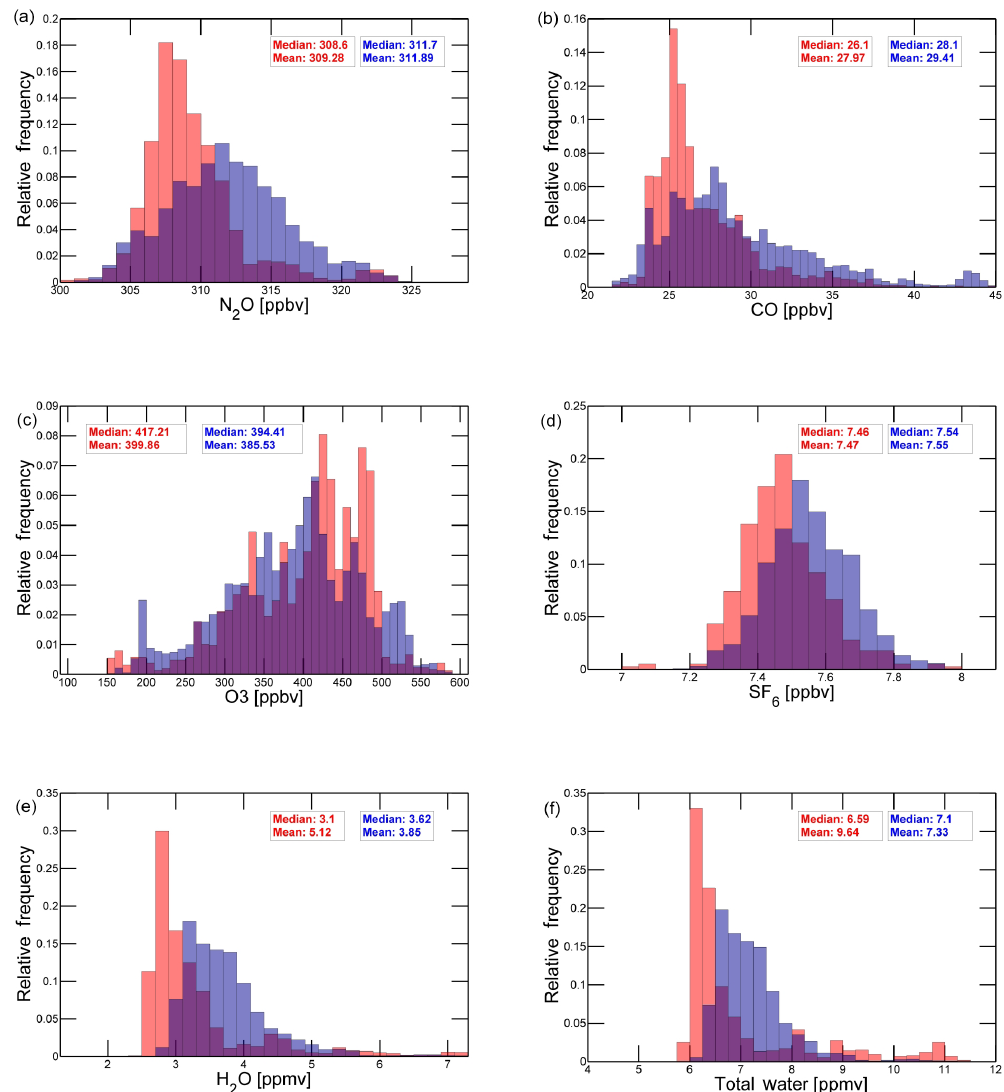
Figure 14. Relative frequency of (a) N 2 O, (b) CO, (c) O 3 , (d) SF 6 , (e) H 2 O, and (f) total water (CH 4 + 2 × H 2 O), for data points with PV > 8pvu. Reddish colours denote the histogram for the initial phase from the 28 August to 5 September, while bluish colours denote those for the final phase of TACTS from 23 to 26 September. Purple areas display the overlap of both histograms.